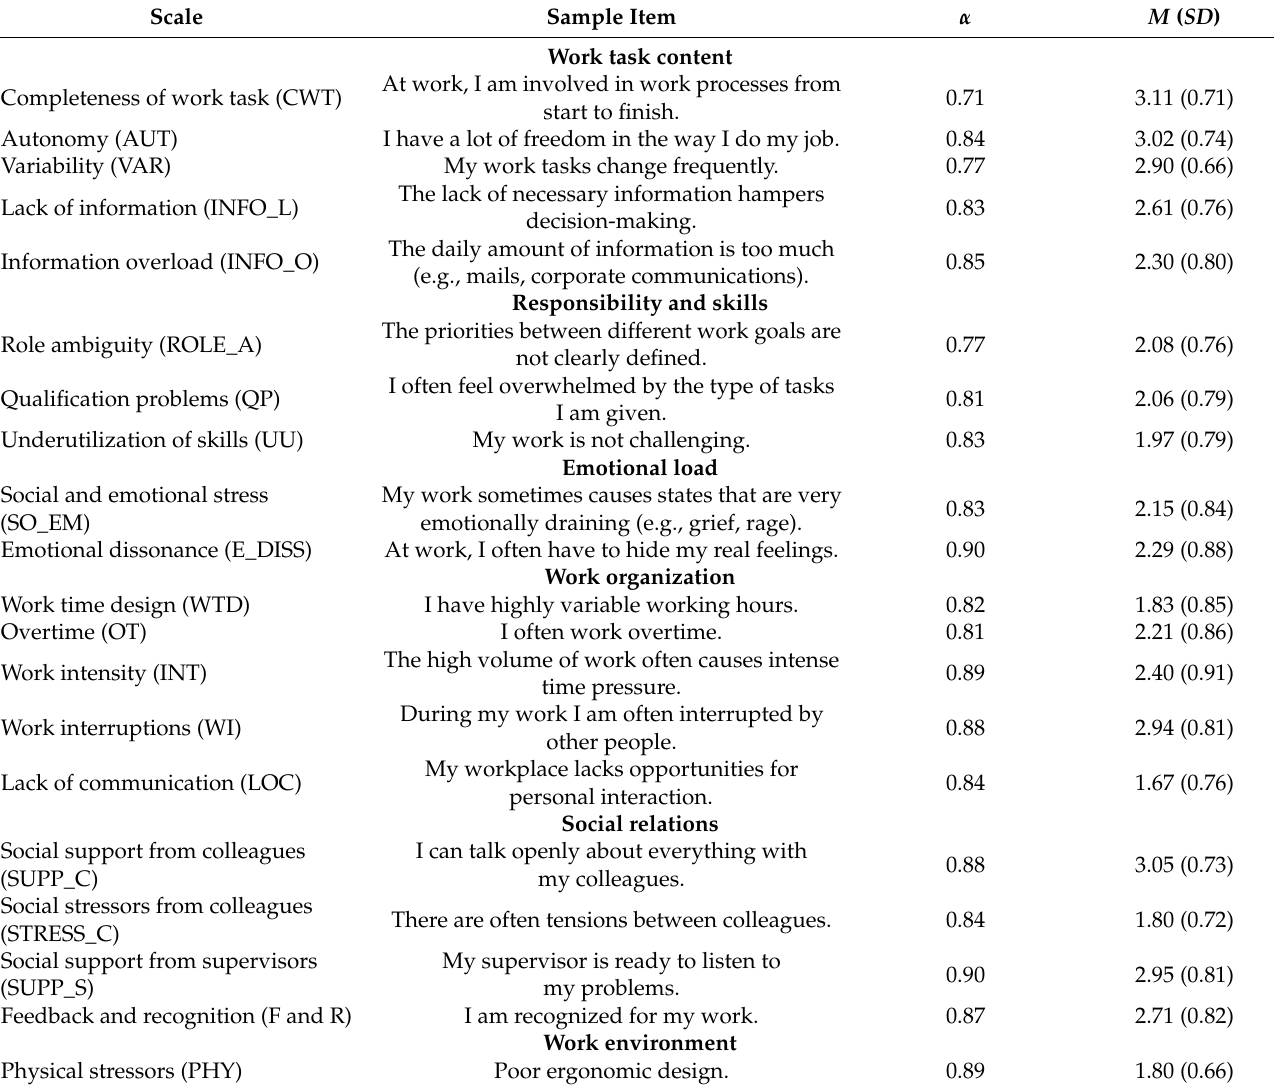
Table 1. Overview of FGBU: scales, sample items, Cronbach’s alphas, means, and standard